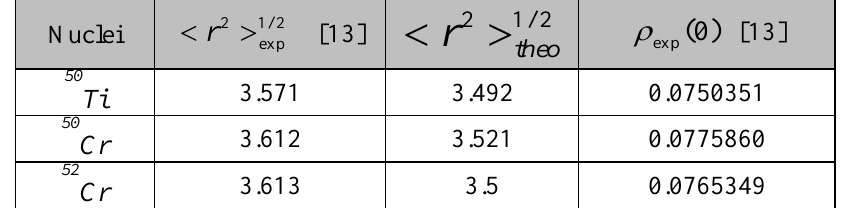
Table 1: The experimental values of 2/1 exp2 r  (in unit of fm ), and (in unit of 3 fm.e  ) used in the present calculations.